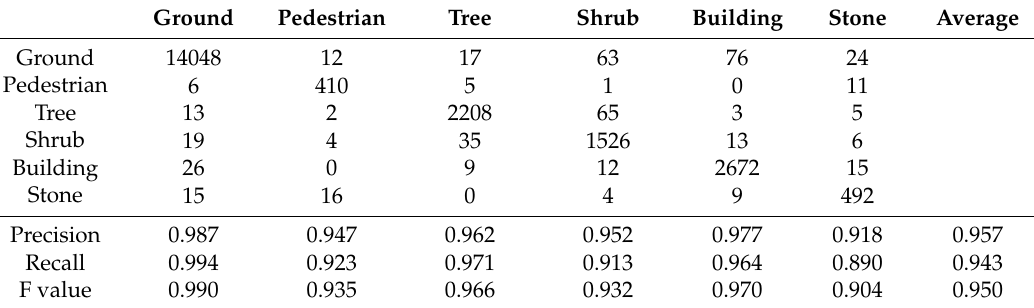
Table 2. Evaluation results of six objects segmentation in Scene